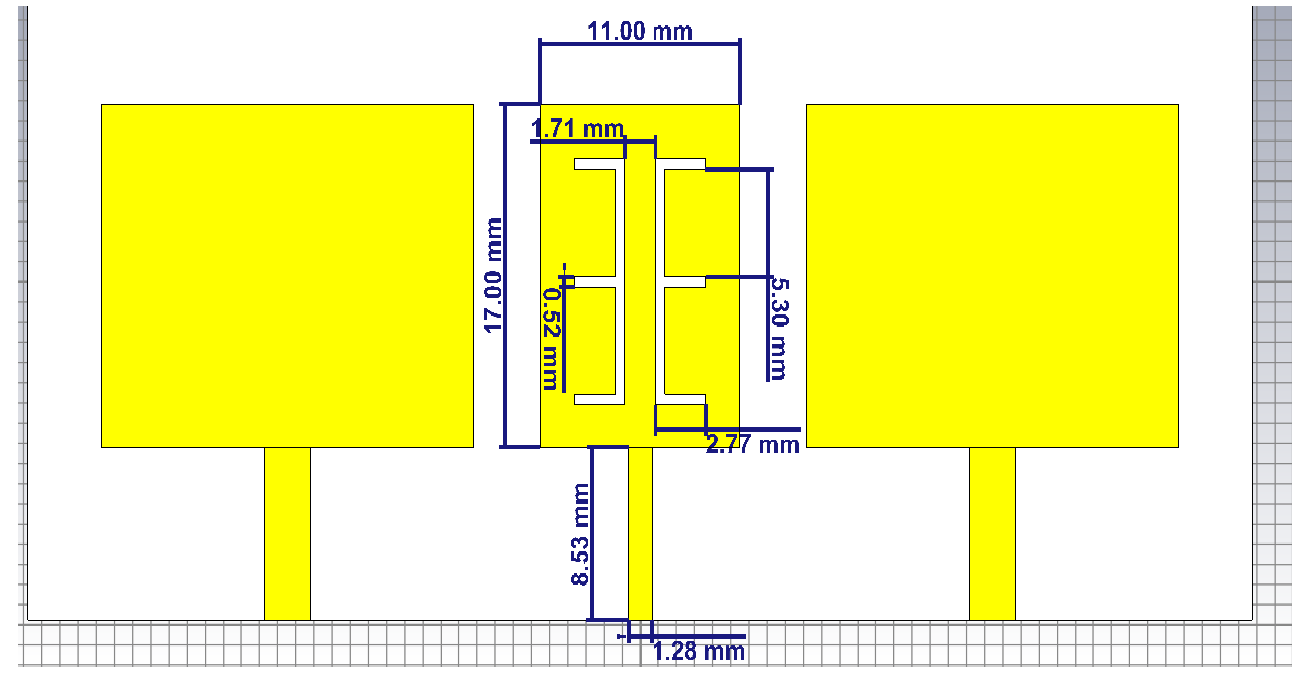
Figure 4. Geometry of 2 × 1 microstrip patch antenna array with MTM-DS.